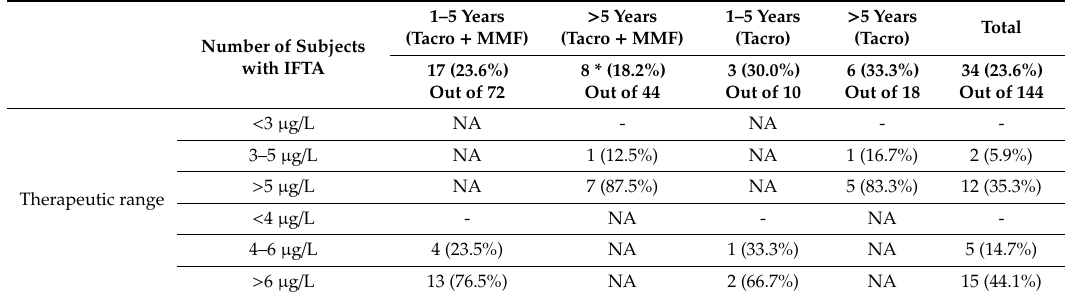
Table 7. Tacro C 0 compliances within therapeutic ranges in patients with kidney